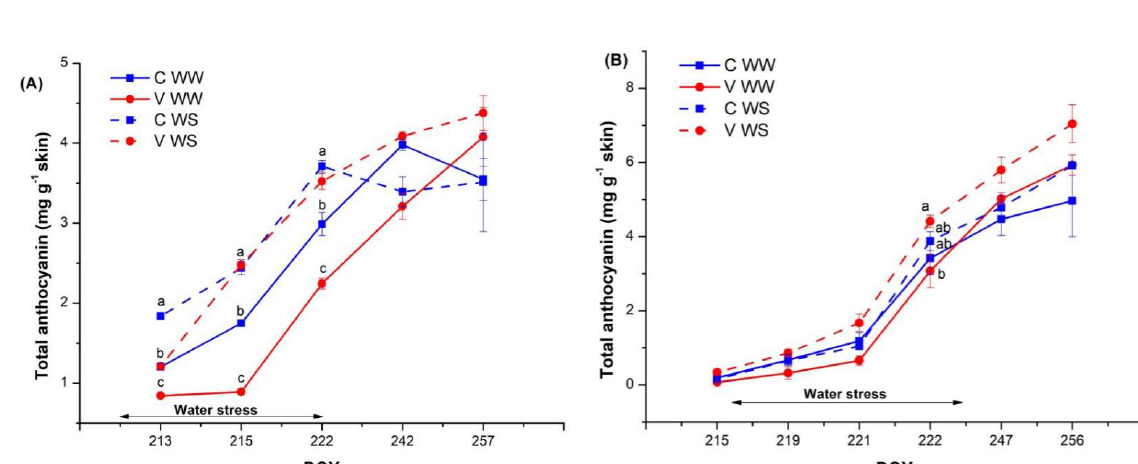
Figure 3. Evolution of total soluble solid content (°Brix) in Sangiovese berries sampled in closed (C) and V (V) canopy-shaped vines under normal water supply (WW) or water stress at veraison (WS) in 2018 ( A ) and 2019 ( B ) seasons. Error bars indicate the mean SE (n = 4). Means followed by different letters differ significantly, as calculated by Tukey test ( p ≤ 0.05). The duration of the water stress period is indicated by black double arrows.